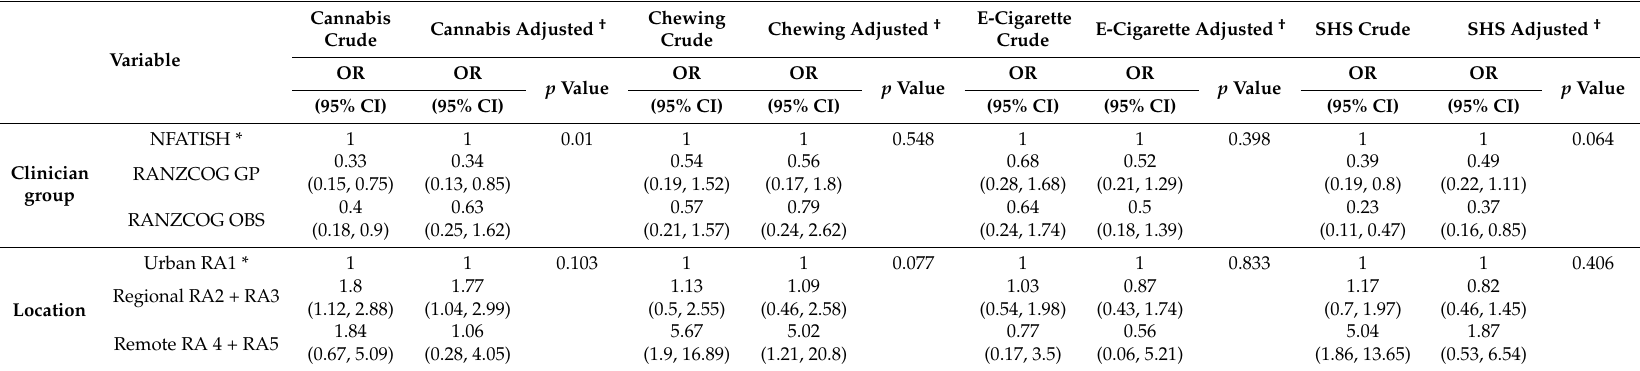
Table 3. Associations between clinician groups, and AGSA-RA, and exposures to cannabis (without tobacco), chewing tobacco, e-cigarettes (with nicotine), and second-hand smoke, in 378 Australian GPs and